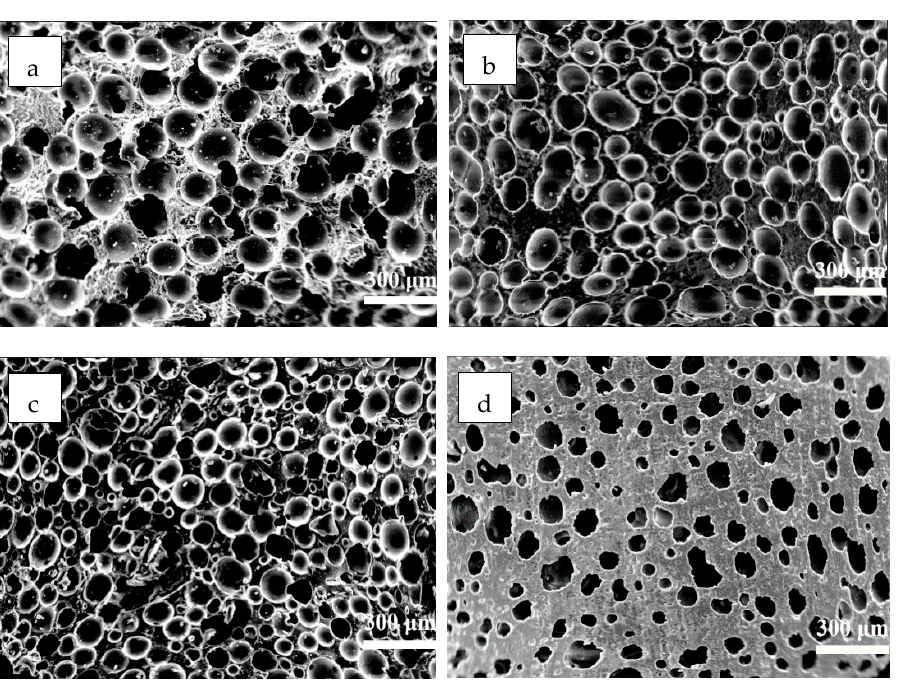
Figure 9. Cross-sectional area of MPUE/EG at the EG content of ( a ) 0 wt%, ( b ) 5 wt%, ( c ) 15 wt%, and ( d ) 30 wt%.